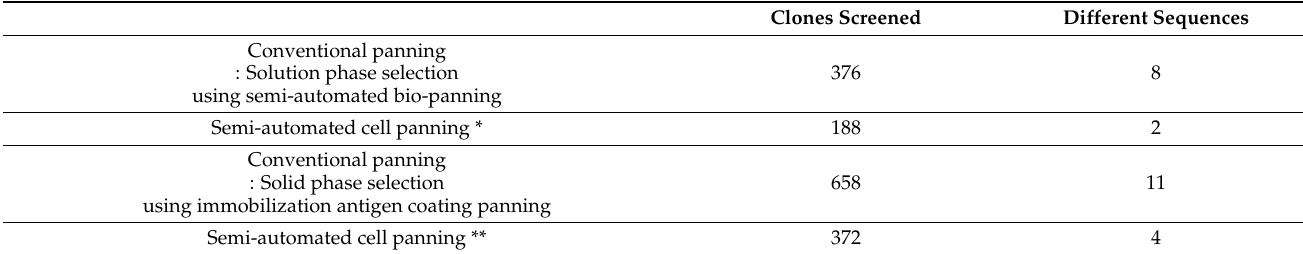
Table 2. Summary of sequenced clones obtained from conventional bio-panning and semi-automated bio-panning. Clones Screened Different